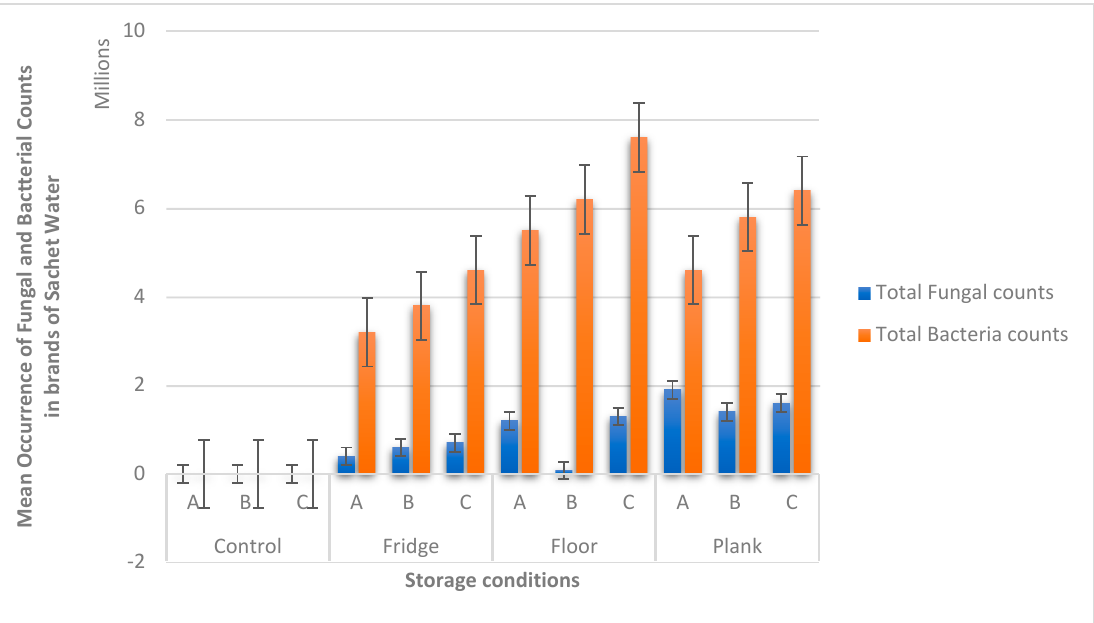
Figure 2. Bar chart diagram showing the occurrence of the total fungal and bacterial counts in the three selected brands of sachet water subjected to different storage conditions.